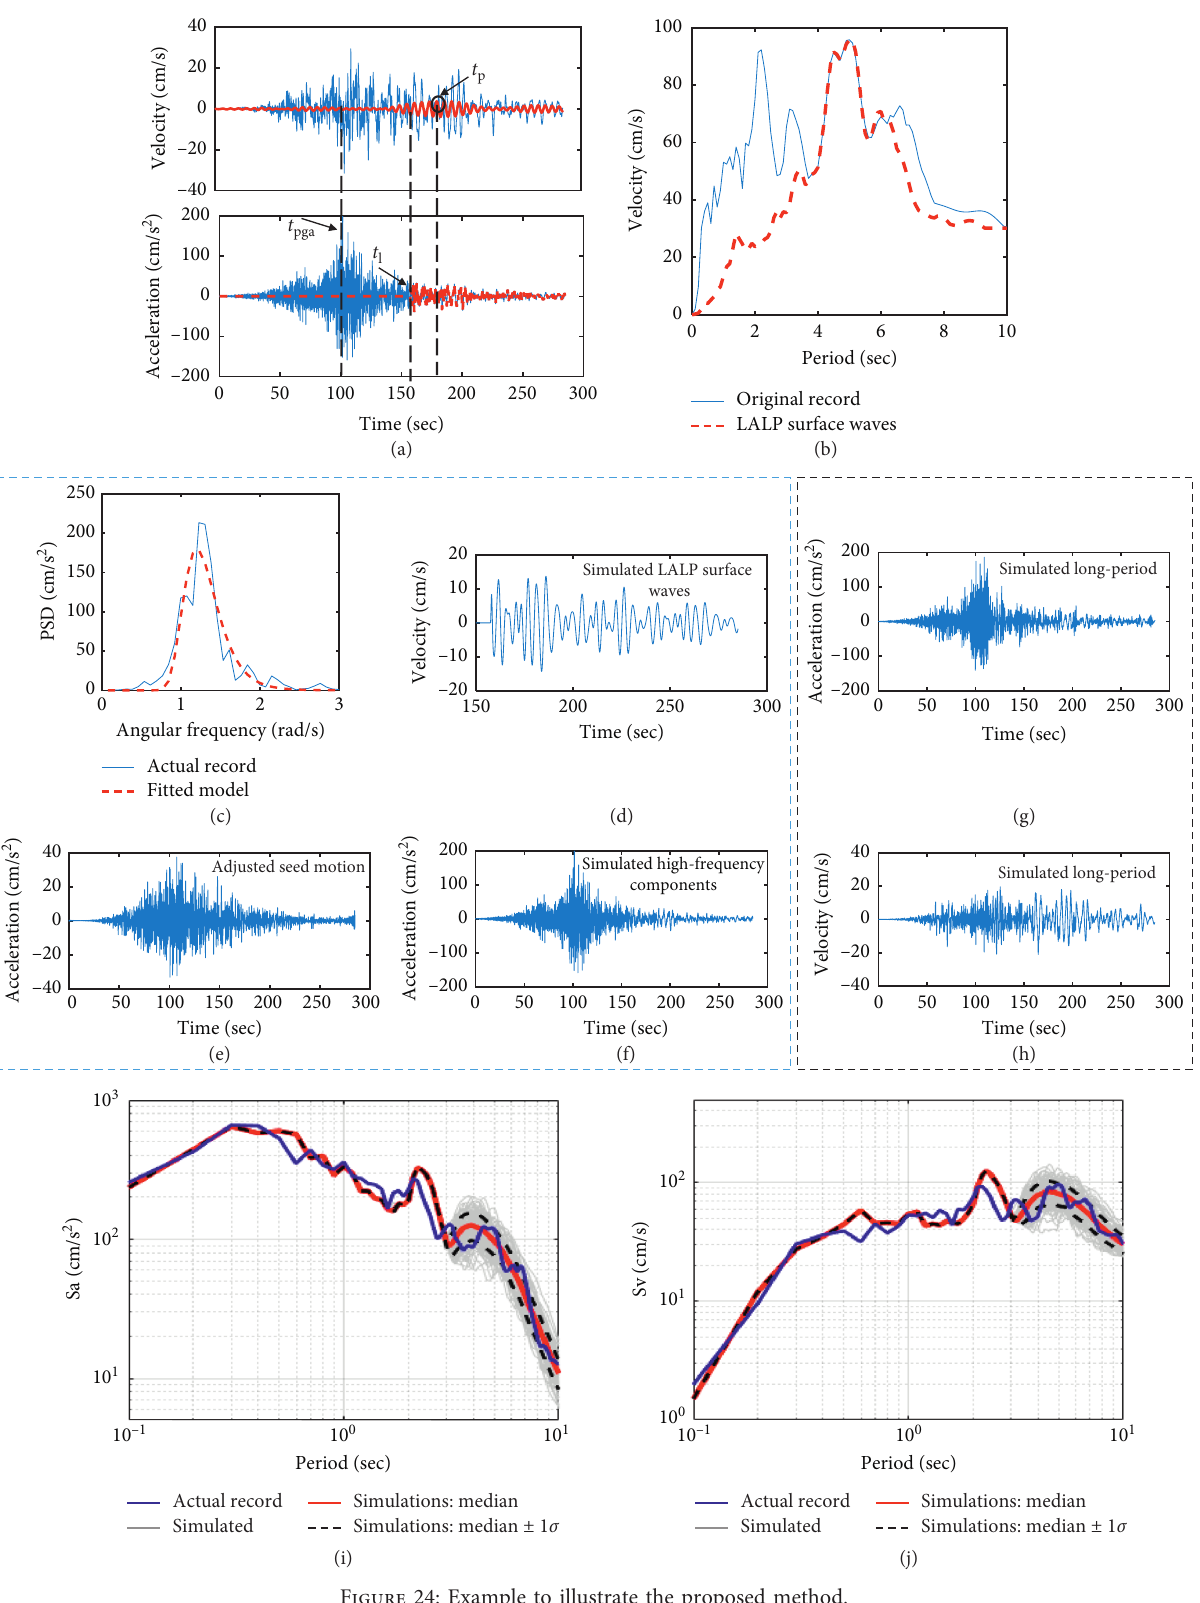
Figure 24: Example to illustrate the proposed